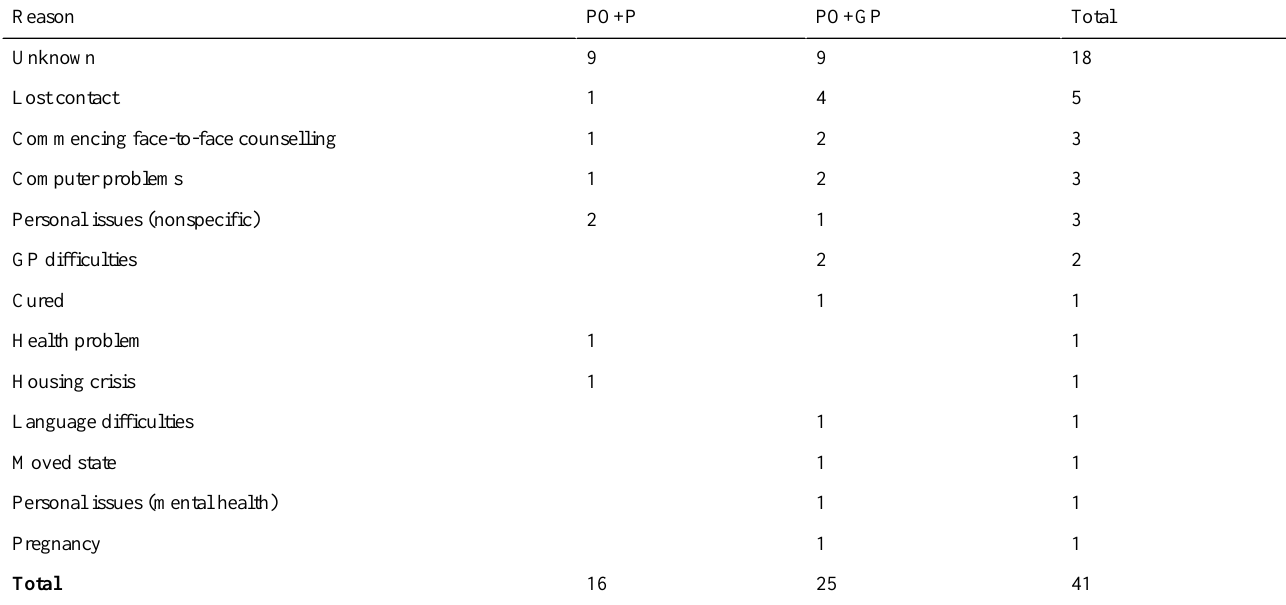
Table 4. Reasons for attrition, by